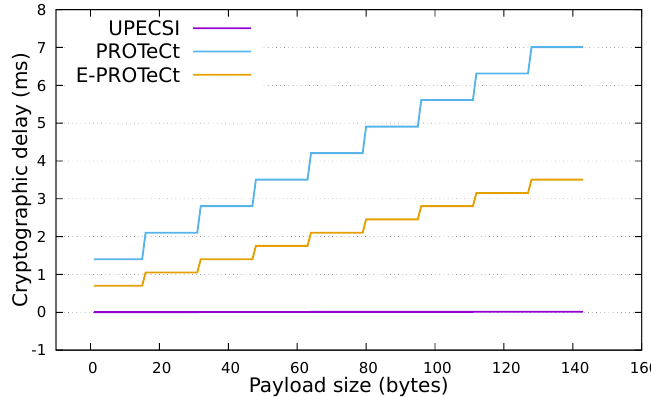
Figure 6. Cryptographic delay for the analyzed